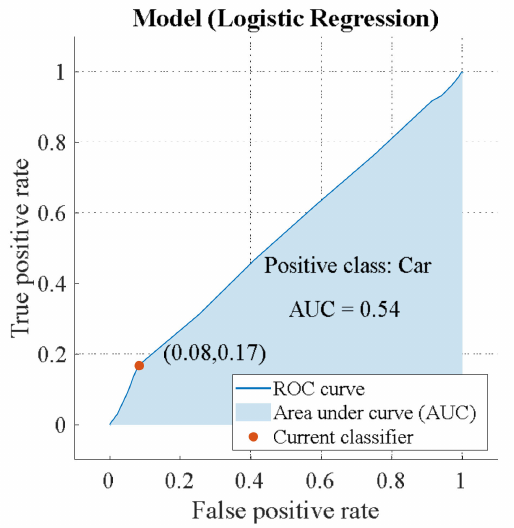
Figure 14. ROC of circular polarization (class “Car”).